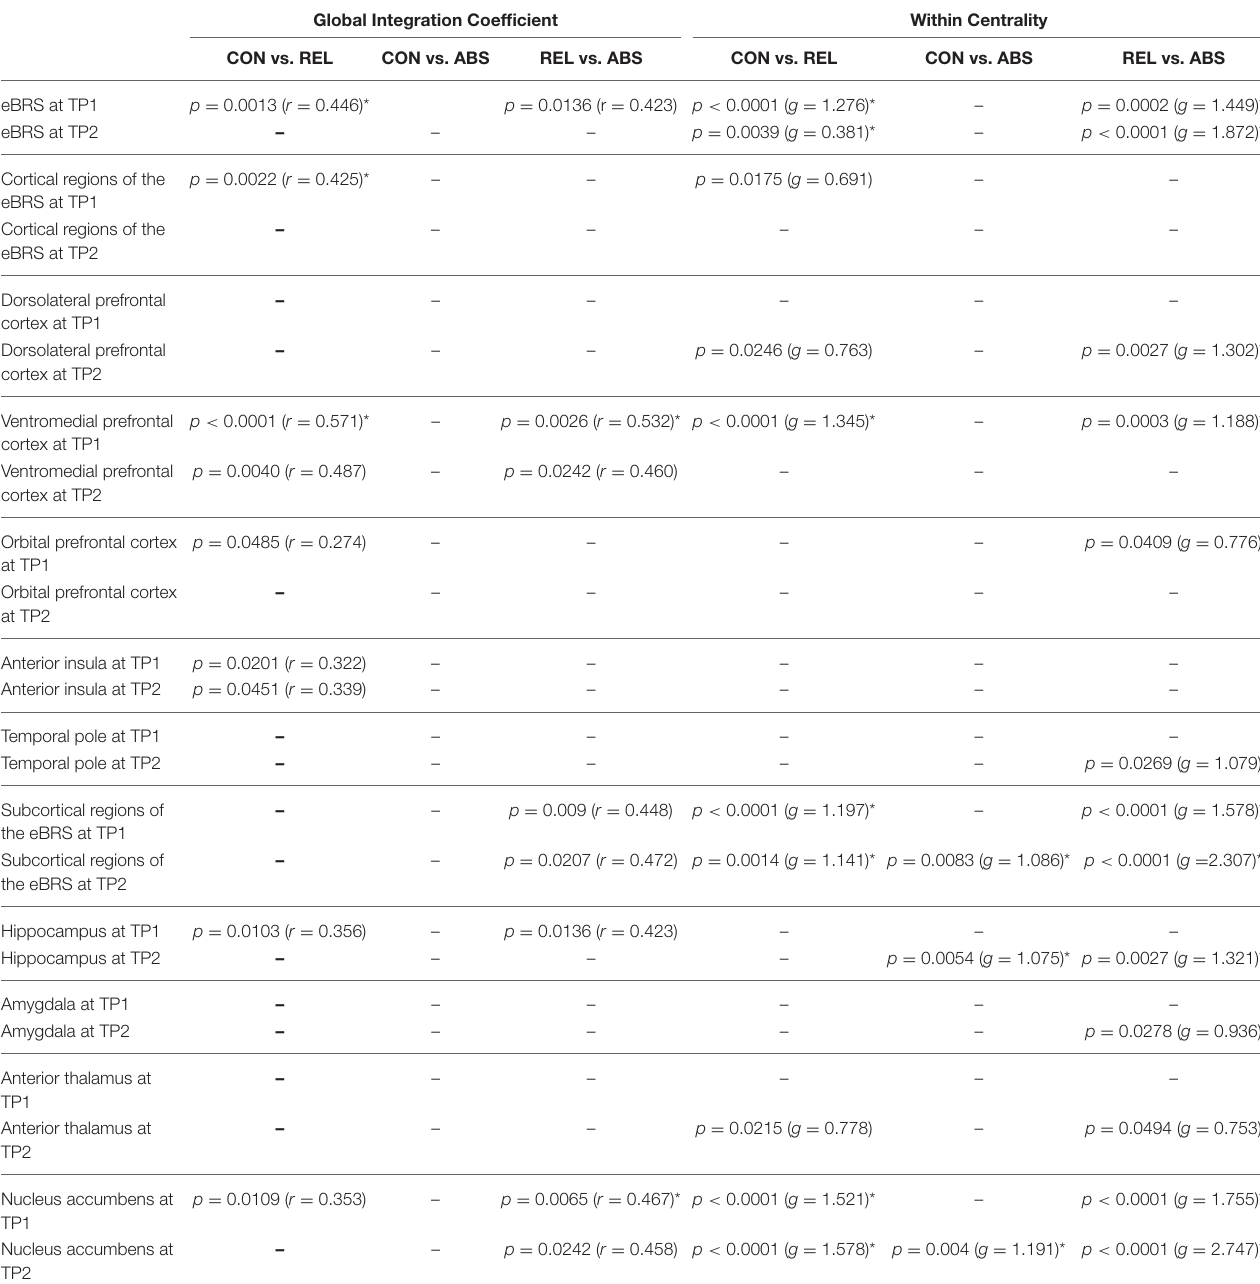
TABLE 4 | List of significant group differences in Global Integration Coefficient (GIC) and Within Centrality of the eBRS at 1 month (TP1) into treatment and at follow-up 3 months later (TP2). Global Integration Coefficient Within